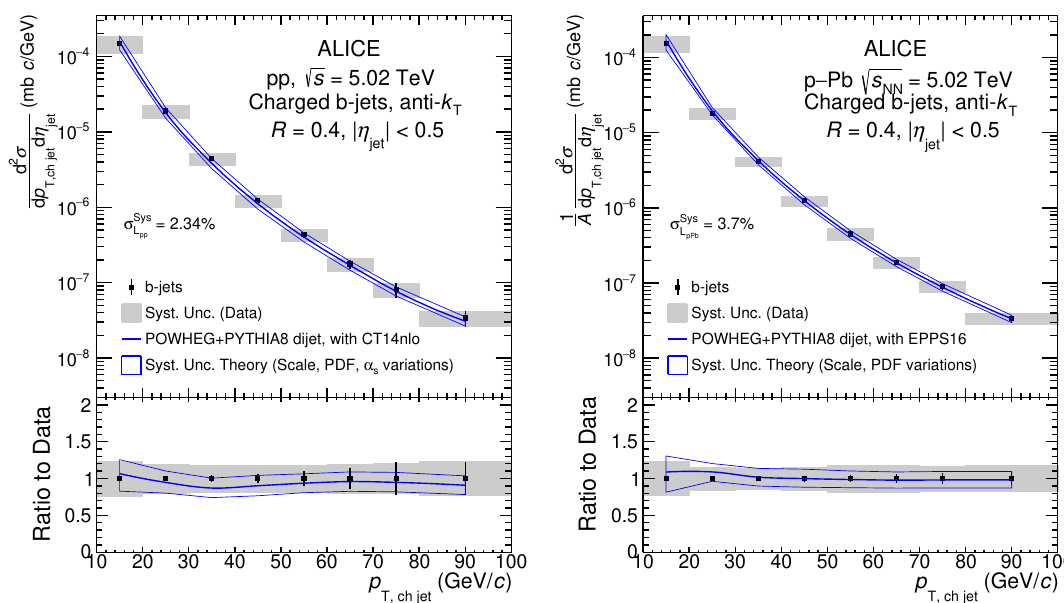
Figure 12. Top panels: the combined differential production cross section of charged-particle anti- k T R = 0 . 4 b jets measured in pp (left) and p-Pb (right) collisions at data are compared with a NLO pQCD prediction by the POWHEG dijet tune with PYTHIA 8 fragmentation [77, 78]. Systematic and statistical uncertainties are shown as boxes and error bars, respectively. The additional common normalization uncertainty due to luminosity, σ Sys separately. Bottom panels: ratio of the theory calculations to the